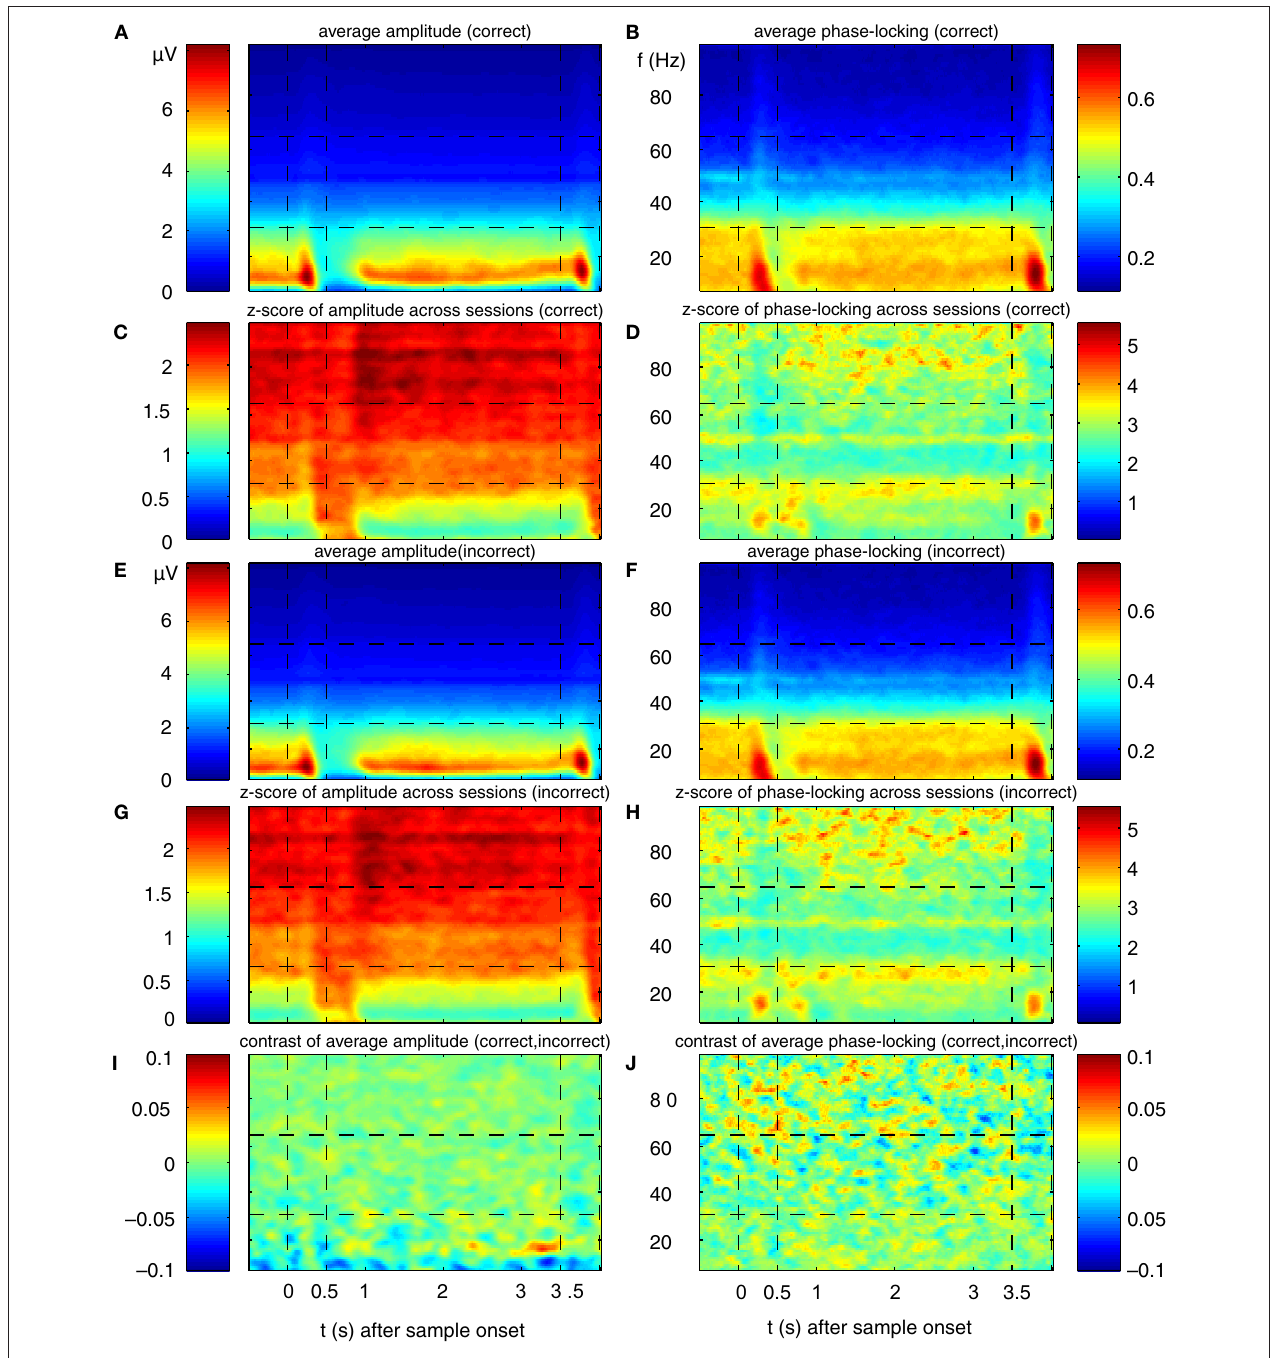
phase-locking plotted for trials with correct and false responses, respectively. (D,H) Z -score for grand average phase-locking in relation to variance (SEM) across experiments for trials with correct and incorrect responses, respectively. (I,J) Contrast of grand average power [(A − E)/(A + E)] and phase-locking [(B − F)/(B + F)] plotted as TF map. The maximum contrast of c = 0.08 indicates a relative difference between trials with correct and false responses of